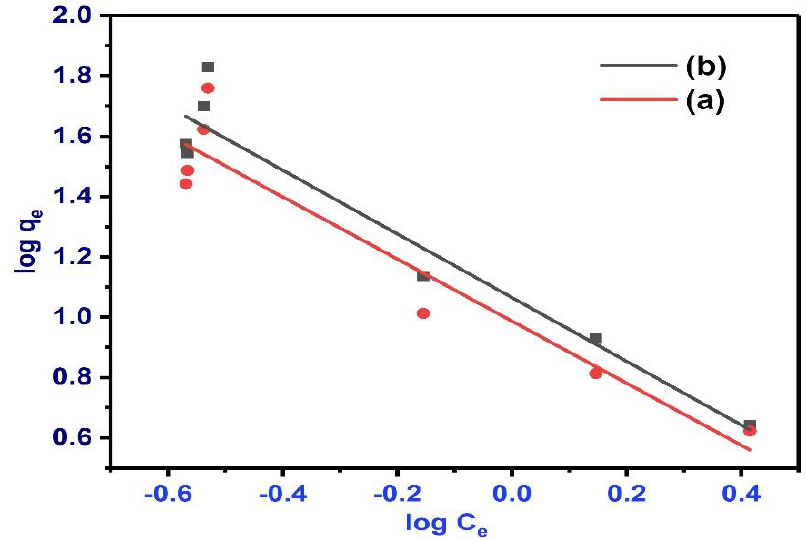
Figure 12. Freundlich isotherm for BPA adsorption onto NBC (a) and MBC (b) at pH 6.0, dose 0.5 g, contact time 240 min, and initial BPA concentration 50 ppm.